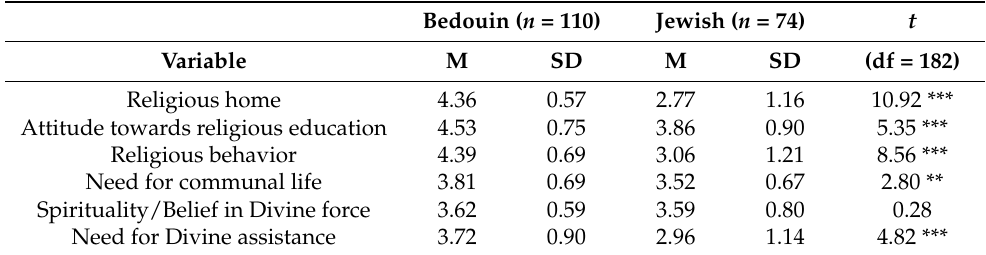
Table 3. Means, standard deviations, and the significance of differences in attitudes towards religion and spirituality between Jewish and Bedouin female students of education. Bedouin ( n = 110) Jewish ( n = 74) t